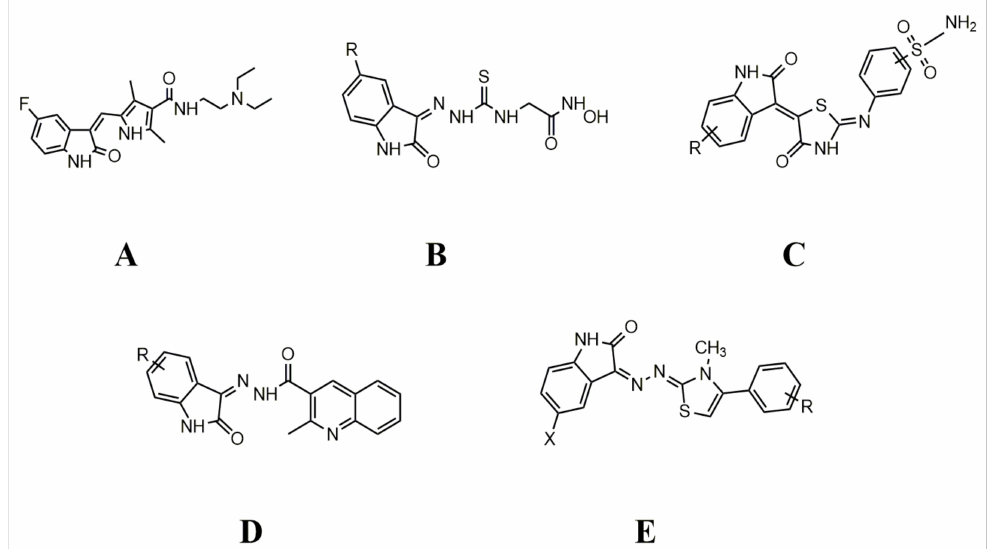
Figure 2. Clinically recognized drugs containing isatin